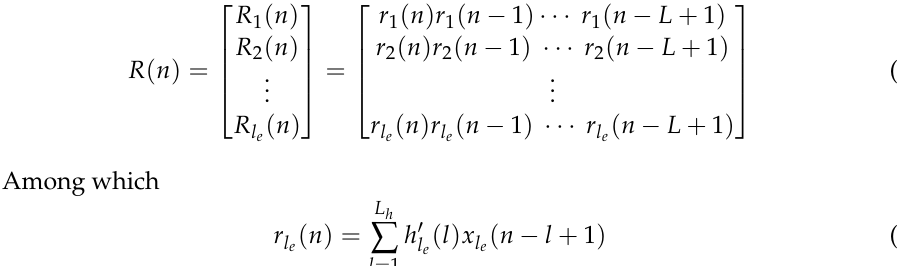
where ' h is the filter coefficient vector of the FIR filter, which simulates the device re- e l l controller to the error sensor, and sponse from the th e ence signal in the previous sampling period. The L e dimensional vector of the control fil- ter coefficient in Equation (9) is constructed as